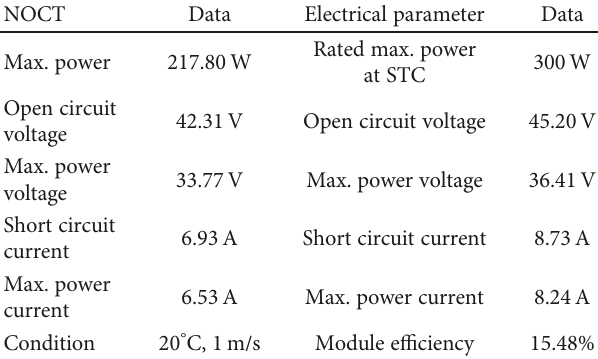
Table 5: Detail of PV module